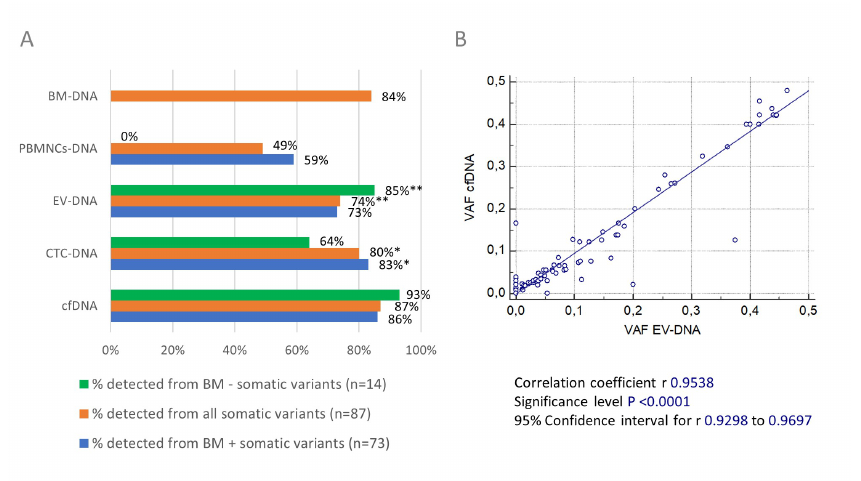
Figure 4. ( A ) Detectability of somatic variants in circulating biomarker and BM DNA samples. The overall detection rate of somatic variants in the five DNA types we studied is shown in orange. In blue, the concordance is shown between the somatic variants detected in BM-DNA and matched circulating biomarker DNA samples. The detection rates of somatic variants uniquely detected in the blood compartment are shown in green. * exclusion of somatic variants detected in 2018-013 ( n = 3) to calculate % because no CTC-DNA sample was available for sequencing; ** exclusion of somatic variants detected in 2018-011 ( n = 1) to calculate % because library preparation failed for EV-DNA sample. ( B ) Correlation between VAFs of somatic variants detected in EV-DNA and cfDNA. The scatter plot shows an almost perfect linear correlation ( p < 0.0001) between the VAFs of somatic variants detected in EV-DNA and cfDNA. Pearson’s correlation coefficient and 95% CI were